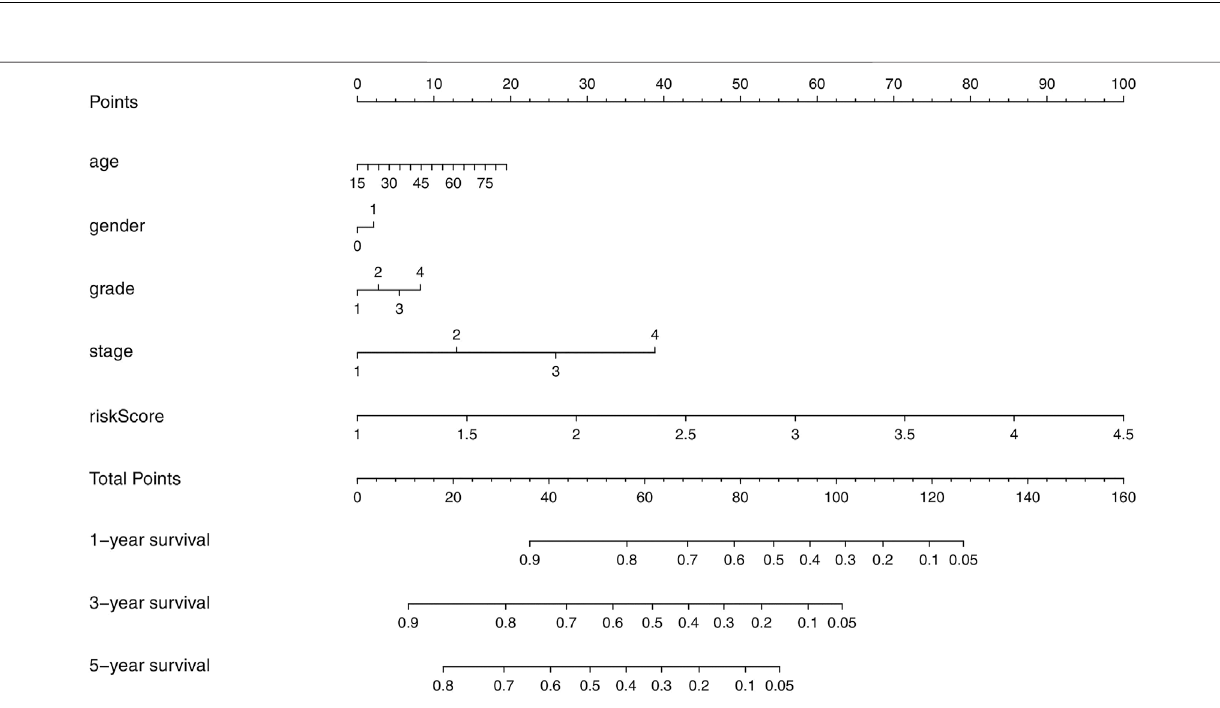
Frontiers in Cell and Developmental Biology |